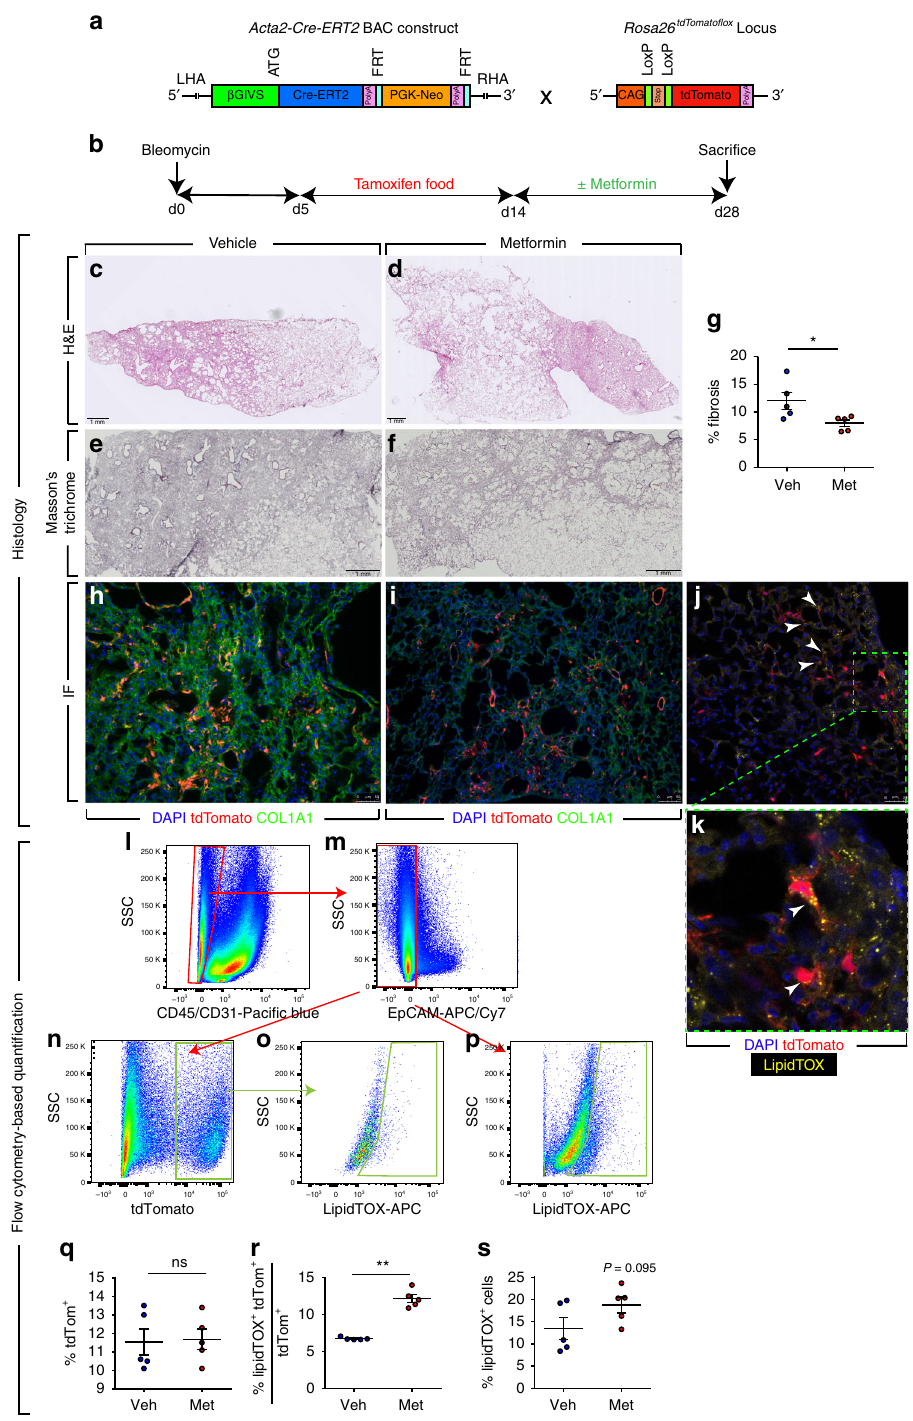
Fig. 4 Metformin accelerates fi brosis resolution in the bleomycin model in mice. a Schematic representation of the Acta2-Cre-ERT2 and tdTomato fl ox constructs. b Schematic representation of the timeline of the experiment. Bleomycin was administered intratracheally at day 0. Between days 5 and 14, mice were fed tamoxifen-containing pellets and starting at day 14, metformin (1.5 mg/mL) or vehicle was administered through drinking water. Mice were sacri fi ced at day 28. c – f Hematoxylin and eosin and Masson ’ s trichrome staining of metformin- and vehicle-treated lungs. g Quanti fi cation of fi brosis in metformin- and vehicle-treated lungs. h , i Immuno fl uorescence for COL1A1 (green). Endogenous tdTomato signal (red) and DAPI (blue) are also shown. j LipidTOX staining (green) and tdTomato + cells (red) are shown. The box in ( j ) is magni fi ed in ( k ). Arrowheads indicate LipidTOX + tdTomato + cells. l – s Gating strategy (to detect CD45 − CD31 − EpCAM − tdTomato + and/or LipidTOX + cells) and quanti fi cation of various cell populations based on tdTomato and LipidTOX detection. Scale bars: c – f 1 mm, h , i 50 μ m, and j 25 µ m. Each data point within a given group corresponds to one animal and error bars indicate s.e.m. n = 5 per group. Mann – Whitney test was used in ( g , q – s ). * P < 0.05, ** P < 0.01. IF: immuno fl uorescence, ns: not signi fi